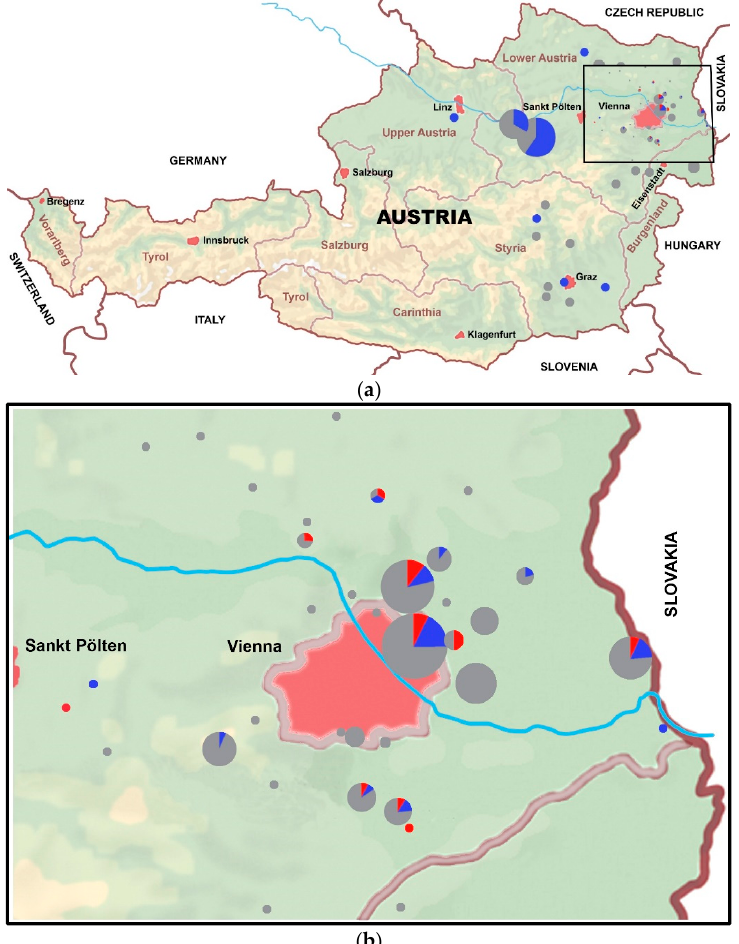
Figure 3. Maps of Austria showing the geographical locations using Google-derived GPS coordi- nates of the sampled equids (Google LLC, Mountain View, CA, USA). The size of the circles corre- lates with the number of equids sampled. Every equid is represented by the outcome of the highest reciprocal neutralizing antibody titer ≥ 20 (PRNT80). The colors represent neutralizing antibody sta- tus. Red represents WNV seropositive, blue TBEV seropositive, and grey flavivirus seronegative